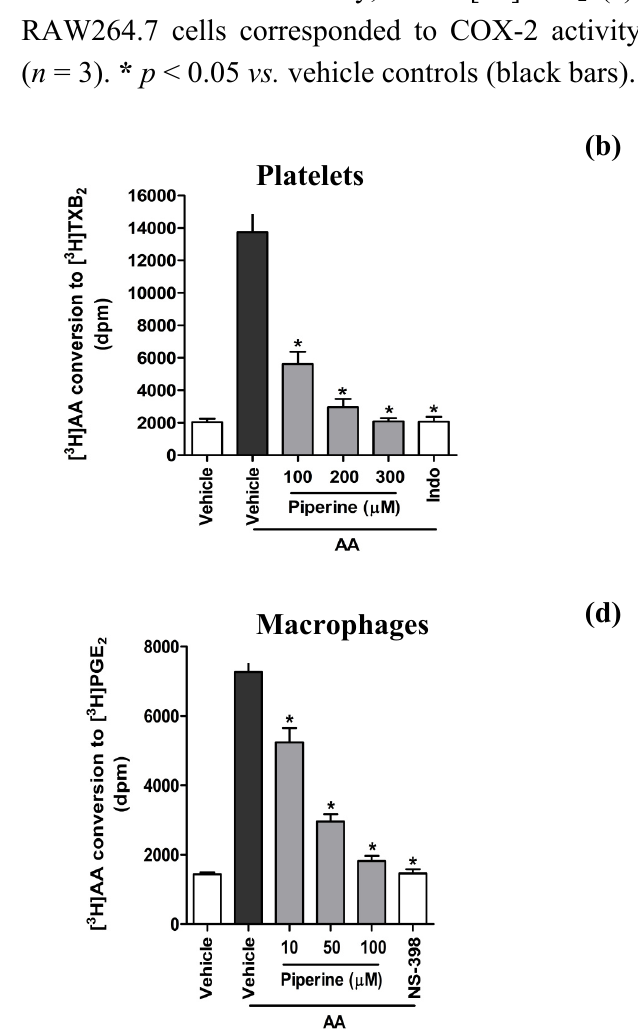
exogenous AA to thromboxane and prostaglandins were measured as a reflection of COX activity. Platelets and RAW264.7 cells were treated with a range of concentrations of piperine, DMSO (vehicle), 50 μ M indomethacin (a COX-1 inhibitor), or 1 μ M